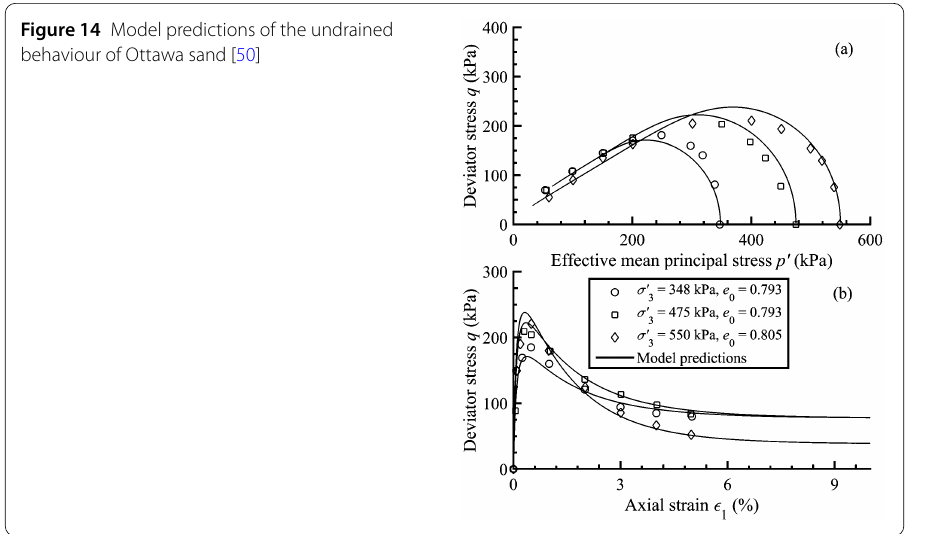
Figure 14 Model predictions of the undrained behaviour of Ottawa sand